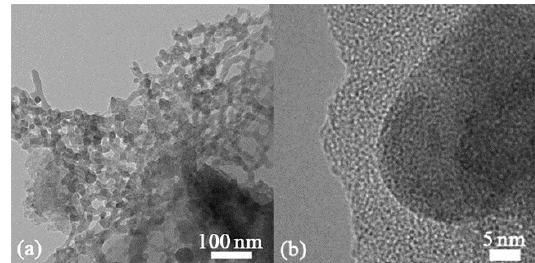
Figure 2. (a) TEM and (b) HRTEM images of the